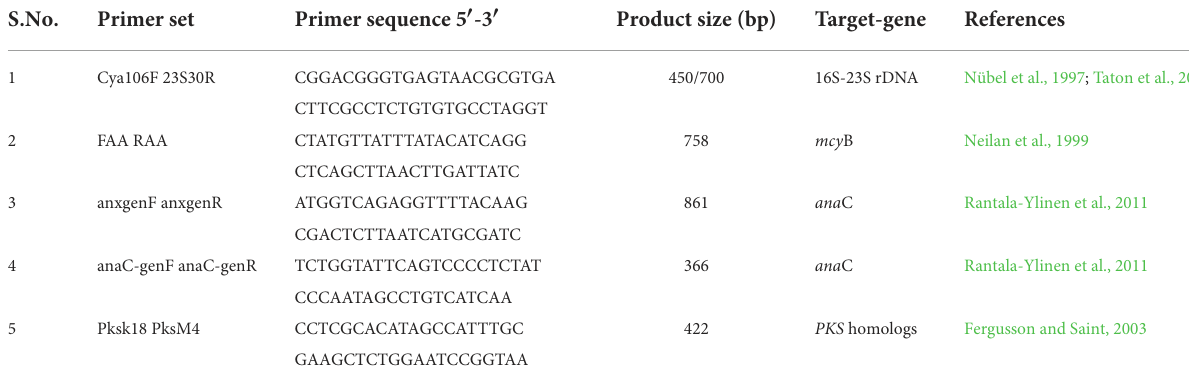
TABLE 1 Primer sets used in conventional PCR for the phylogenic characterization of cyanobacteria and detection of cyanotoxin biosynthesis gene clusters.